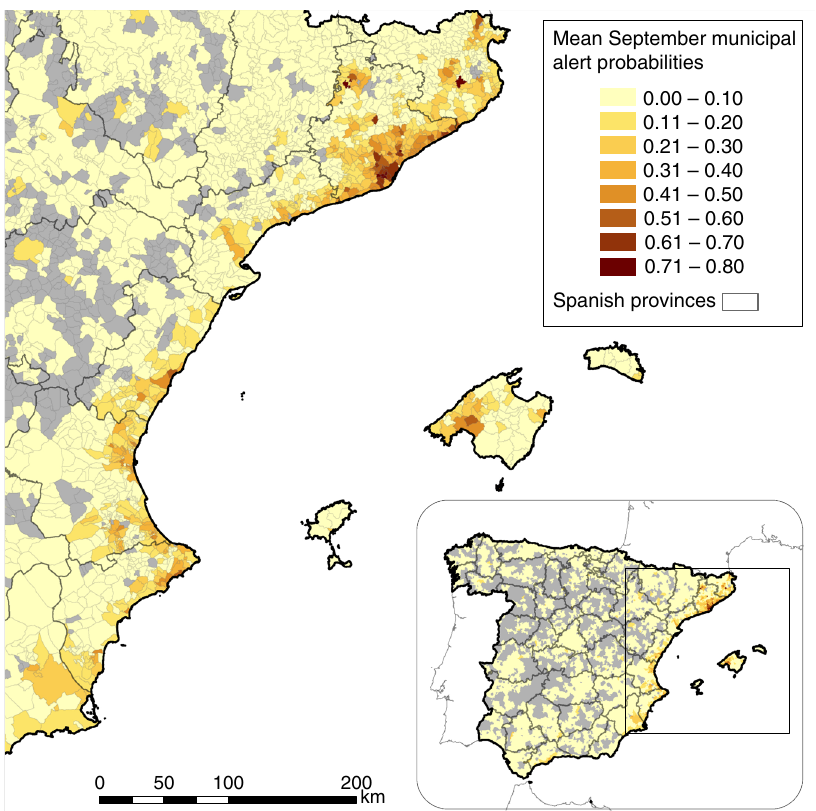
Fig. 5 Mean September municipal alert probabilities in Spain (Canary Islands, Ceuta and Melilla excluded), based on 2014 – 2015 Mosquito Alert reliable reports. Grey municipalities were not sampled by Mosquito Alert participants during this period. Boundary data from Spanish National